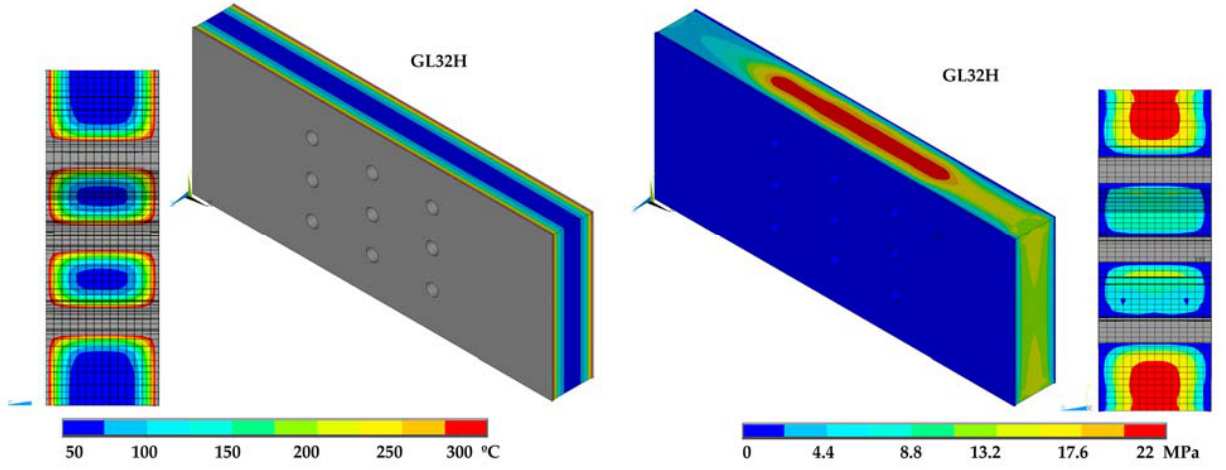
Figure 22. Temperature ( left ) and equivalent stress (von Mises) ( right ) in the wood element, both with the middle cross ‐ section, at 300 s.